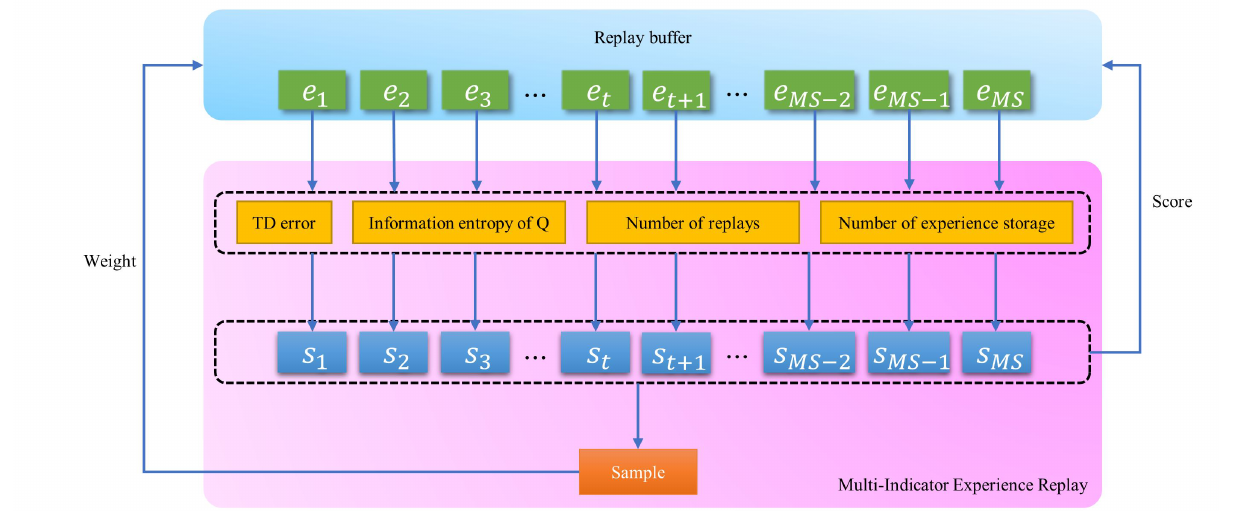
Figure 4. Process of multi-indicator experience